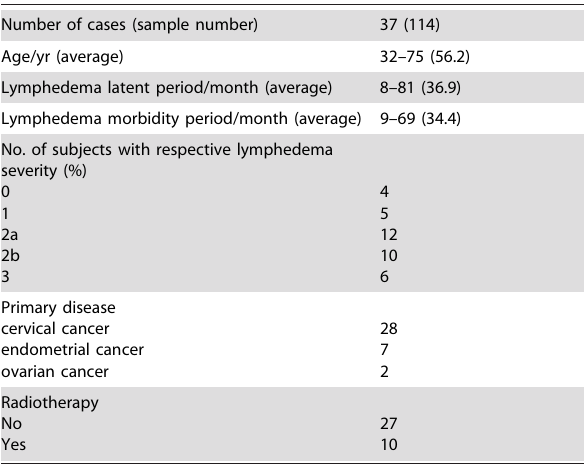
Table 1. Case summary.